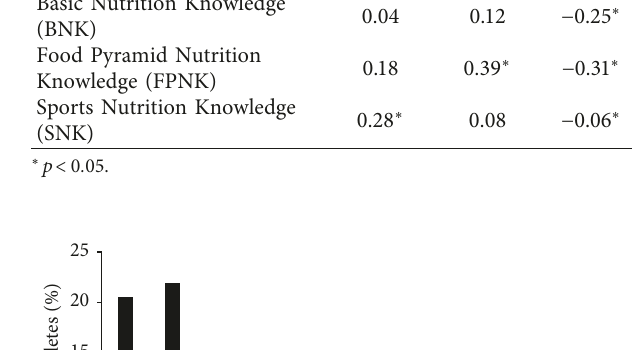
Table 2: Pearson’s correlation coefficients among athlete’s nutri- tion knowledge and dietary intake ( n